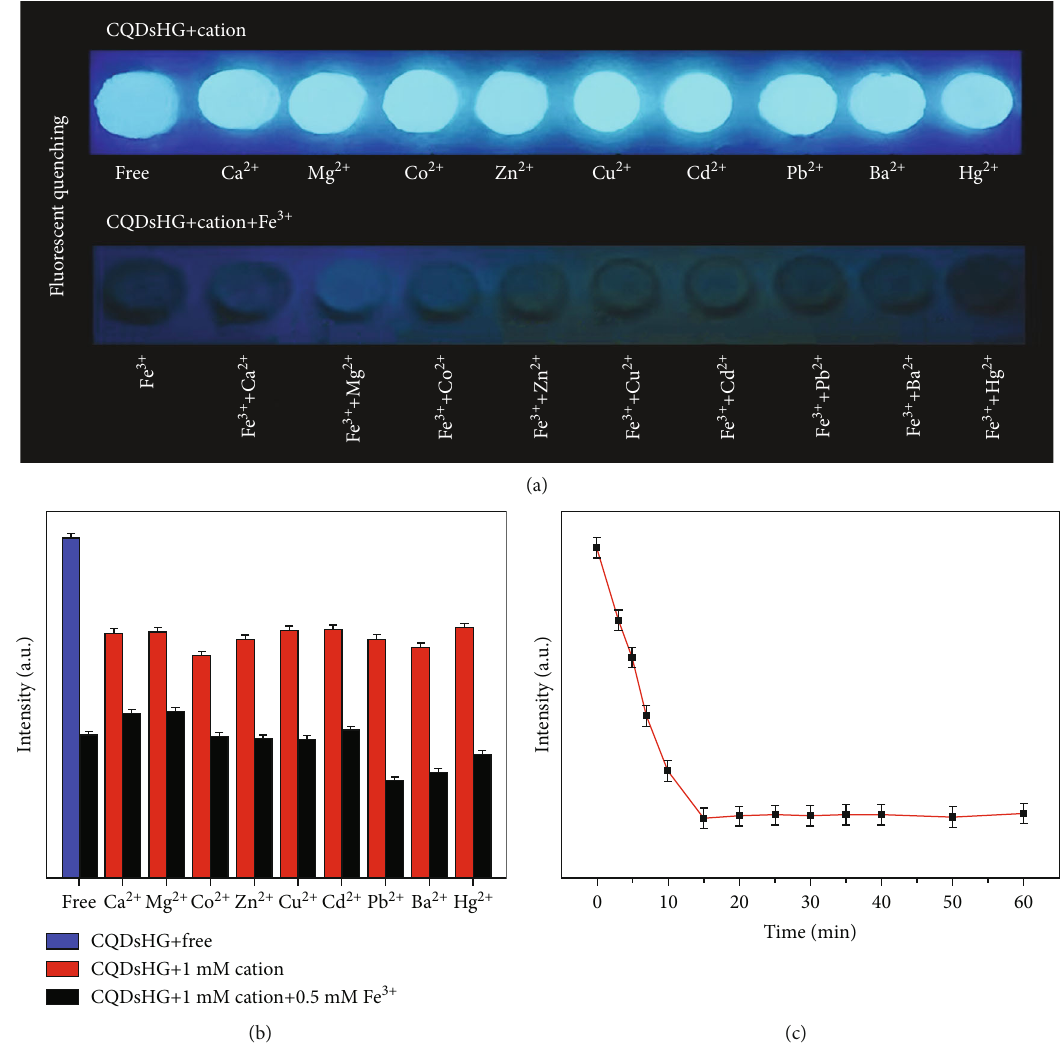
Figure 7: (a) Fluorescence behavior of the CQDsHG under the interfering ions (UV 365nm), (b) the quenching e ff ect and selectivity of the CQDsHG to di ff erent metal ions, and (c) in fl uence of the CQDsHG adsorption time on fl uorescence